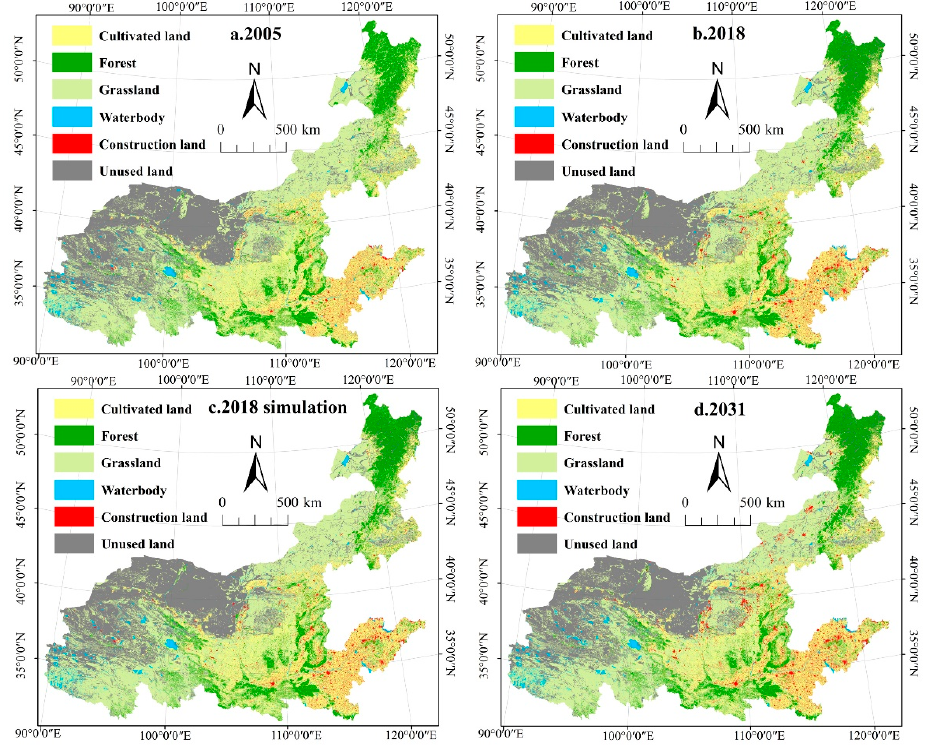
Figure 2. The land-use simulation map of the Yellow River Basin. ( a ). 2005 represents the land use of the Yellow River Basin in 2005; ( b ). 2018 represents the land use of the Yellow River Basin in 2018; ( c ). 2018 simulation represents the simulated land use of the Yellow River Basin in 2018; ( d ). 2031 represents the simulated land use of the Yellow River Basin in 2031. Table 3. Landscape type structure of the Yellow River Basin from 2005 to 2031 (unit: 10 4 km 2 ).